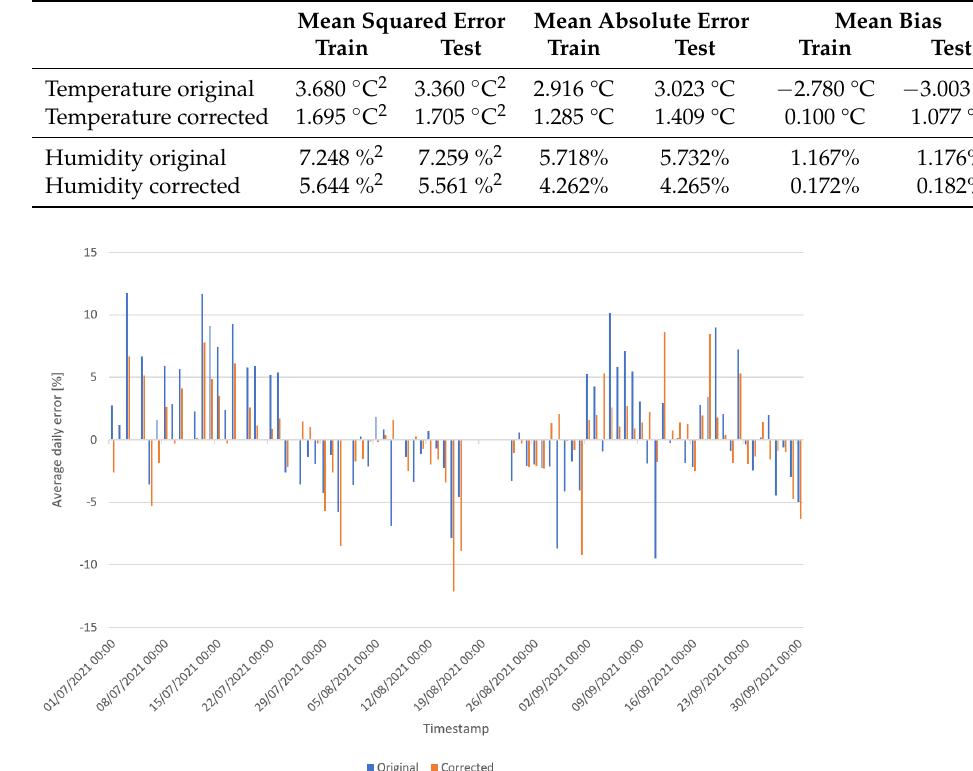
Table 3. Results of corrections on measurements.